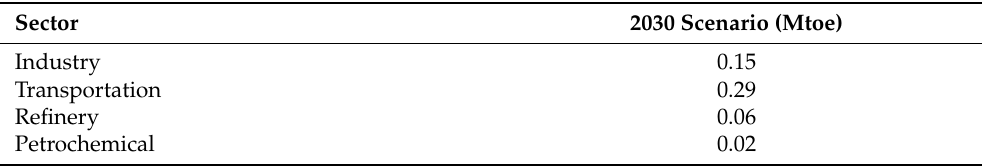
Table 3. Green hydrogen consumption by